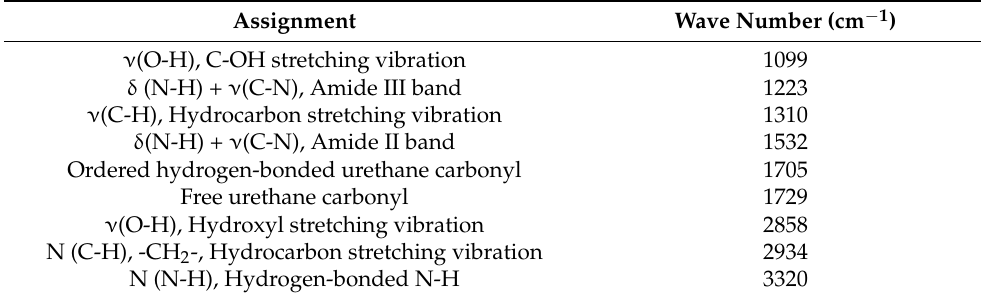
Figure 4. FTIR spectra of the PUMEs at 23 °C ± 2 °C.